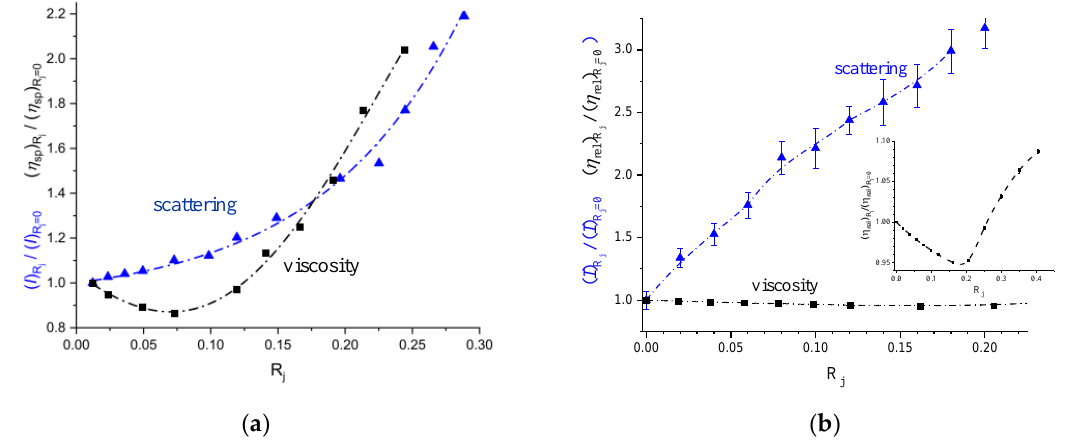
Figure 12. Dependence on the R j of the ratio of the experimental property at R j over the same property at R j = 0; full blue triangles: scattering intensity at 90°, I ; full black squares: specific viscosity, η sp . ( a ) pectate (data from refs. [33,34]; ( b ) L. hyp. alginate (data from ref. [18]).